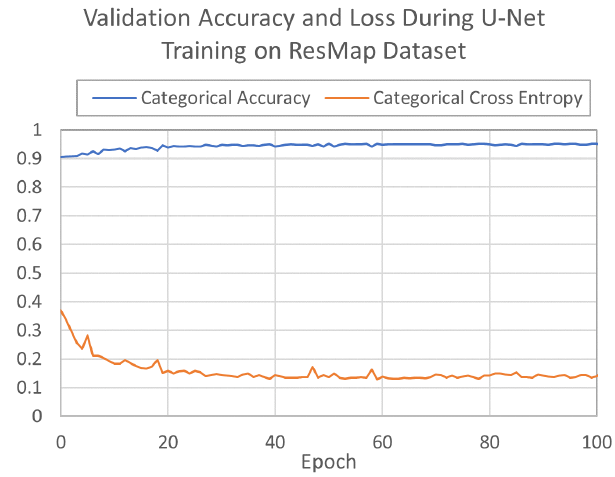
Figure 5. U-Net validation accuracy and loss when training on ResMap data set.